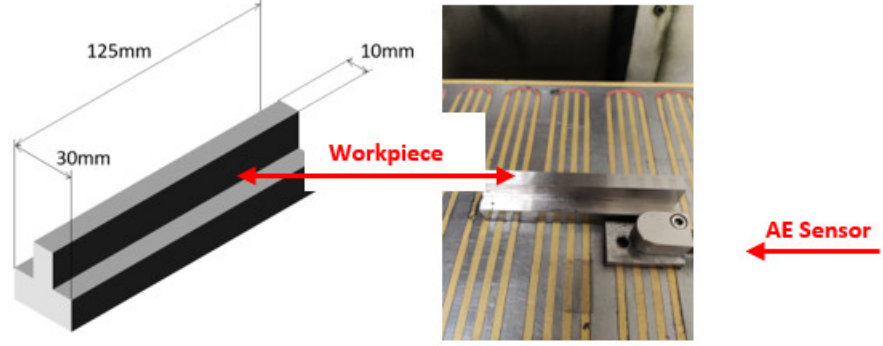
Figure 1. ( Left ): Steel part geometry. ( Right ): Set-up of the AE sensor on the magnetic table.